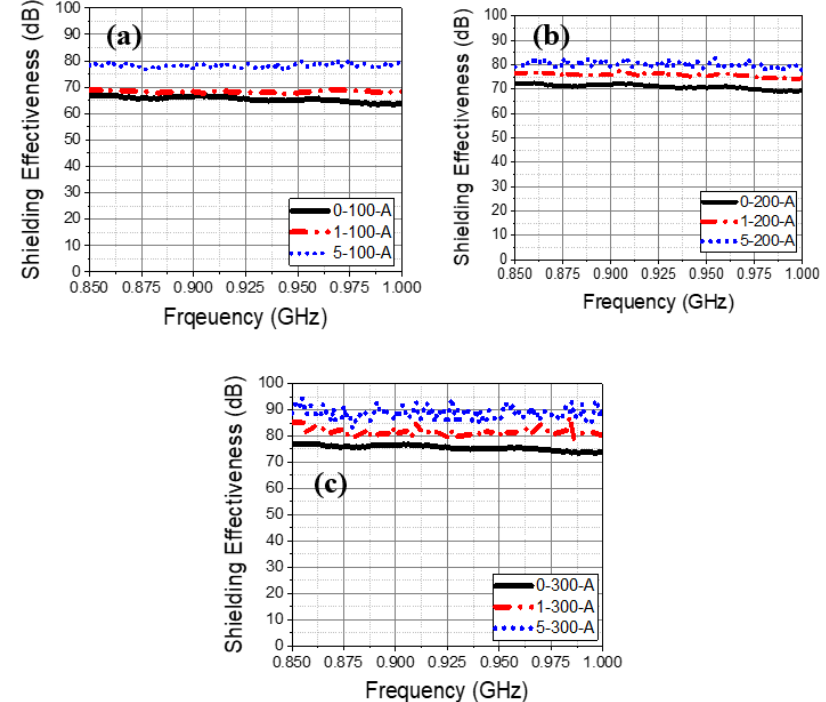
Figure 9. Shielding effectiveness vs. studied frequencies plots using the Zn – Al coating for ( a ) 100, ( b ) 200, and ( c ) 300 mm concrete thickness with 1 and 5 wt% carbon black.